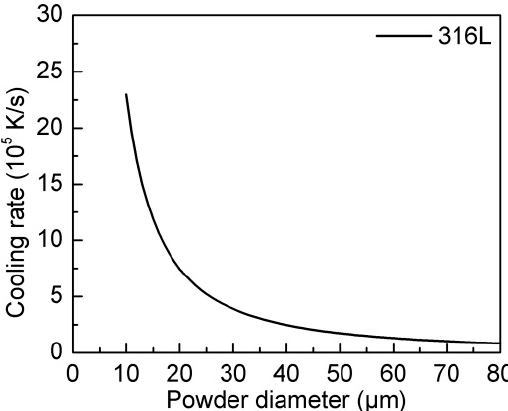
Figure 10. Calculated cooling rate of 316L droplets as a function of droplet diameter.